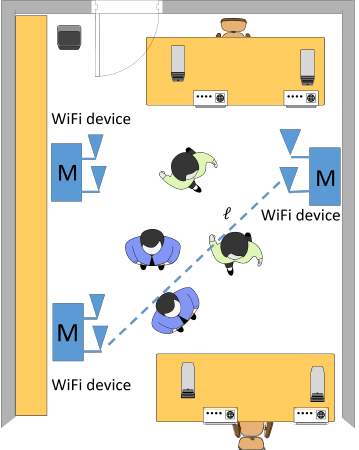
Figure 1. Crowd sensing using a WiFi network composed by N t transmitting and N r receiving MIMO WiFi devices. Each MIMO WiFi device is equipped with M antennas while M t = N t M and M r = N r M are the total number of transmitting and receiving antennas,